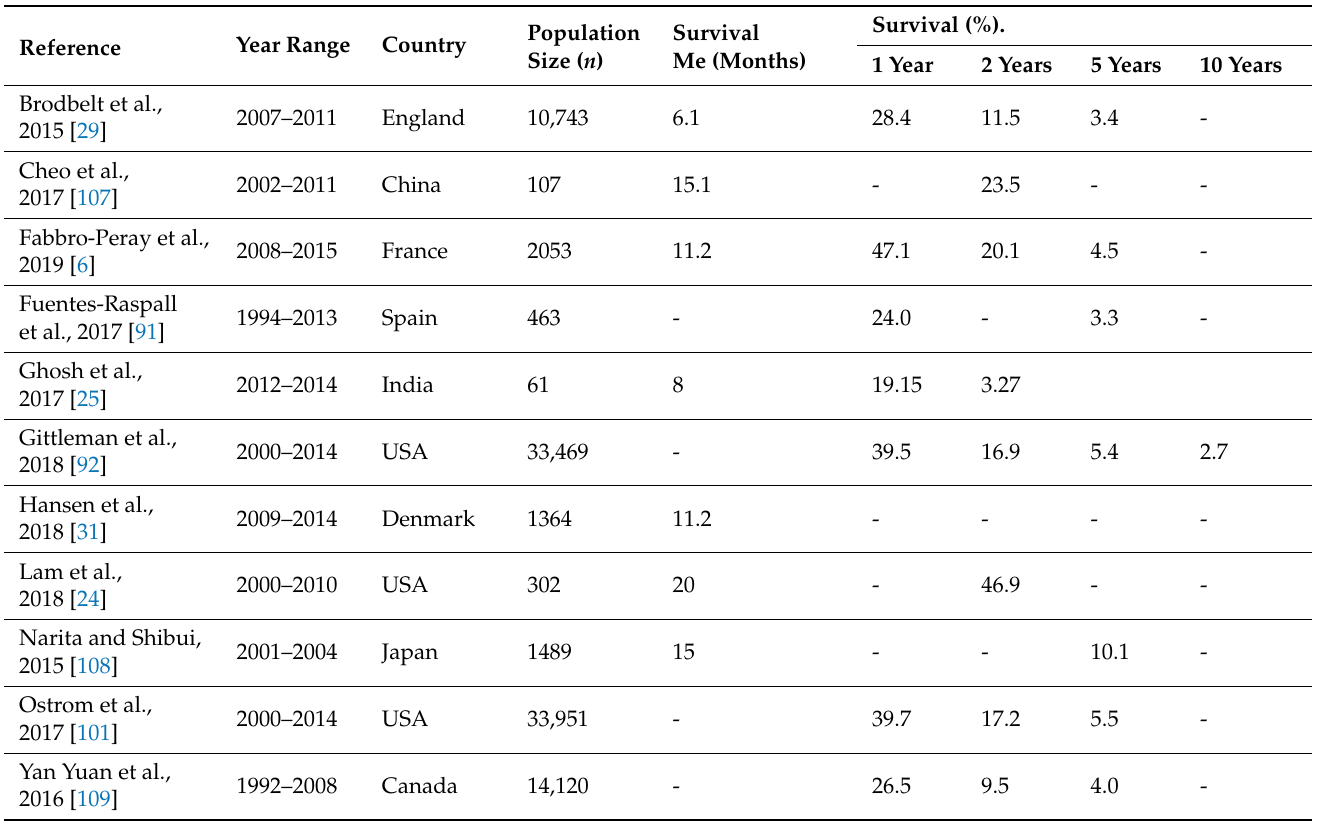
Table 2. Survival time of GBM patients.